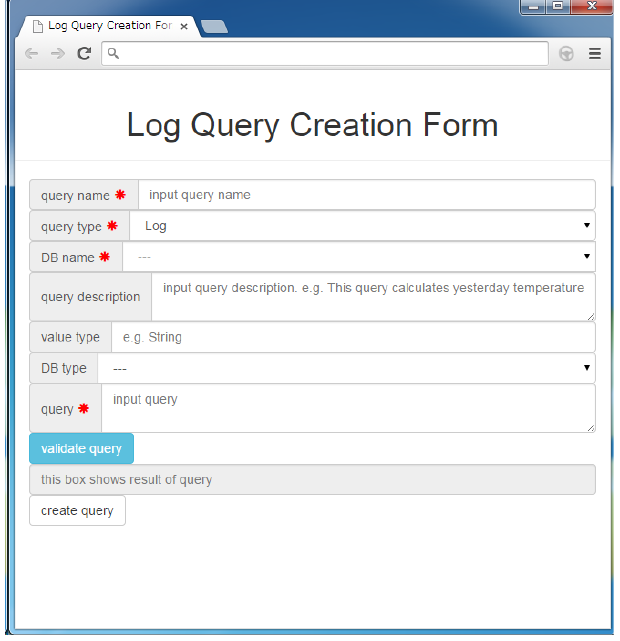
Figure 5. Log query creation form